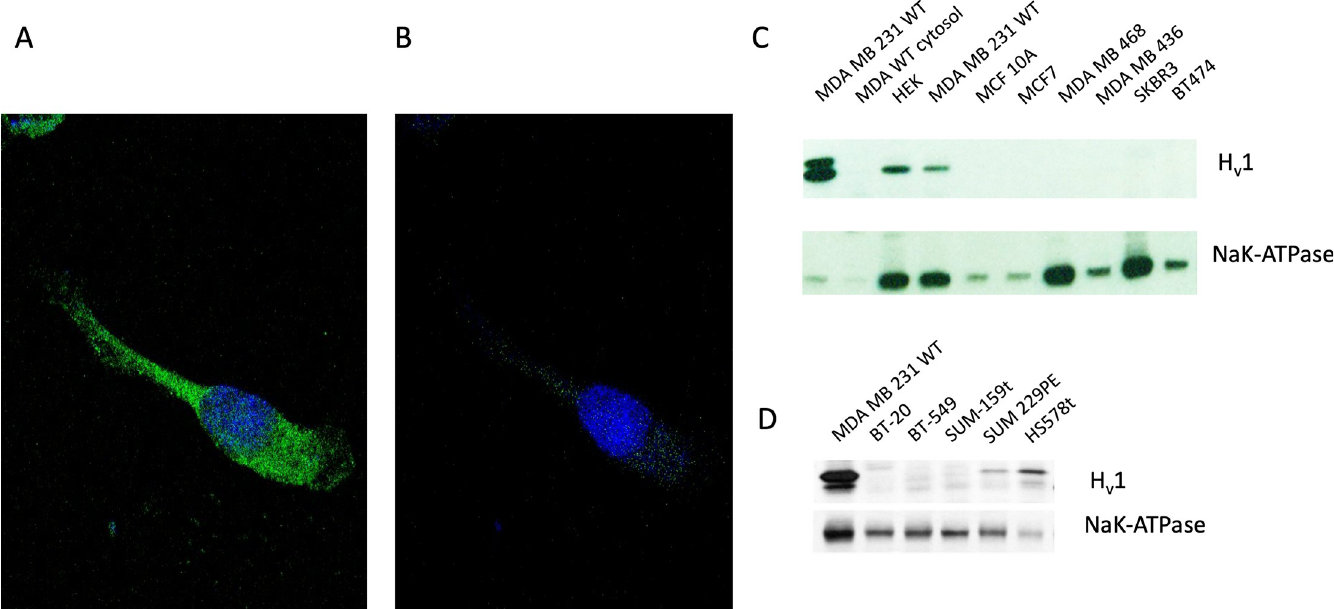
Fig 2. H V 1 protein is present in the plasma membrane of MDA-MB-231 cells and in other triple-negative breast cancer cell lines. ( A ) An MDA-MB-231 cell permeabilized with Triton X-100 and stained with an antibody specific for H V 1 with the image focused on the plane of the membrane surface. ( B) Shows the fluorescence of the same cell but with the focus centered through the nucleus (a confocal midpoint plane positioned relative to the total nuclear thickness) and thus, deeper into the cytosol. The nucleus was stained with DAPI and is visible in both A and B . ( C ) Western blotting of membrane fractions from a number of different breast cancer cell lines. Membrane fractions were stained with antibodies specific to H V 1 and Na + /K + -ATPase as a membrane fraction loading control. The top pair of blots examines membranes from a number of cells representative of the major types of breast cancer, i.e., Luminal A, Luminal B, Her2 and triple negative. ( D ) Western blots from 6 different triple negative breast cancer